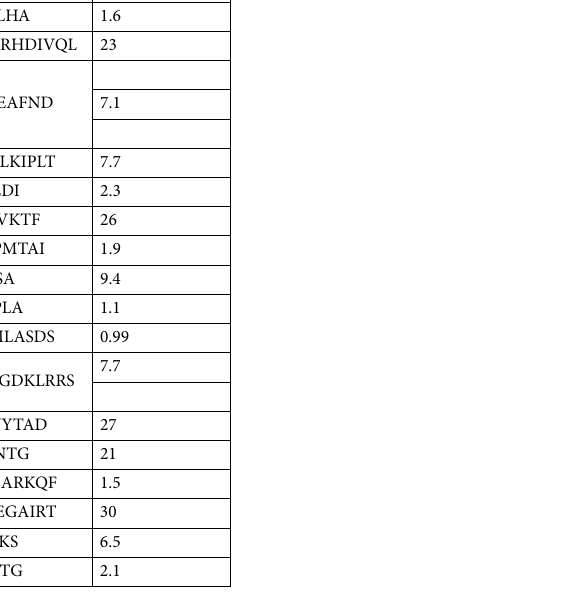
Table 4. MHC-I and MHC-II predicted